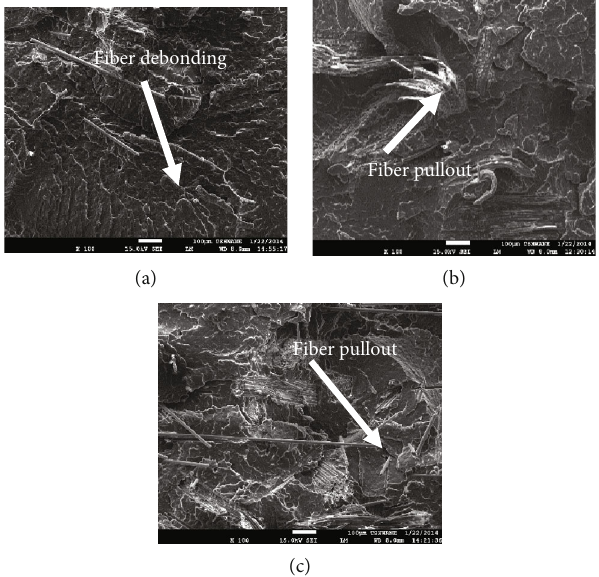
Figure 7: SEM images of the KA1, KA2, and KA4 KOH-treated fi ber composites.